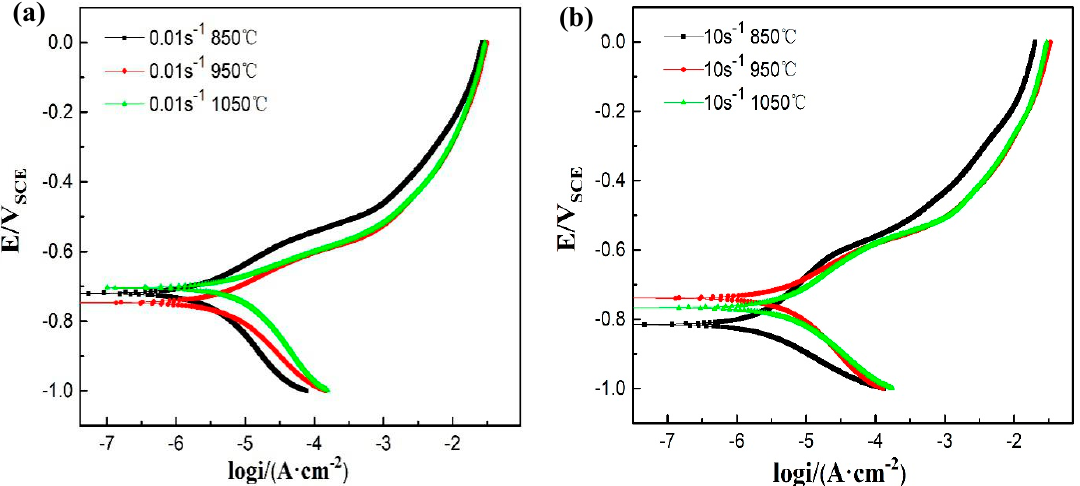
Figure 5. Polarization curves of 35CrMoV steel in 3.5 wt% NaCl solution: ( a ) 0.01 s − 1 , 850–1050 °C; and ( b ) 10 s − 1 , 850–1050 °C.